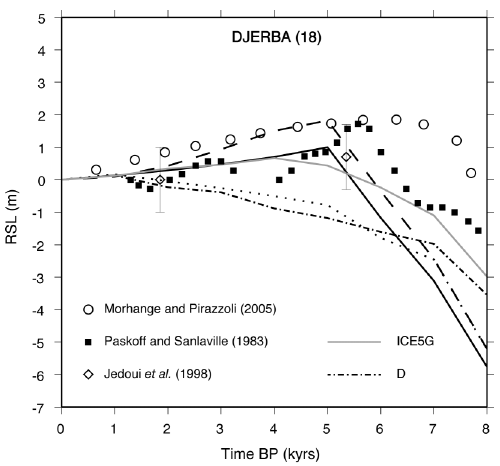
Fig. 13. RSL observations for Djerba according to various sources, and predictions using ice models ICE3G(S) (solid line), ICE3G(G) (dashed), ICE3G(D) (dotted), and ICE5G (solid grey). A dash-dotted curve shows results obtained assuming that the Antarctic ice sheet model D of fig. 9 is the only active load since the